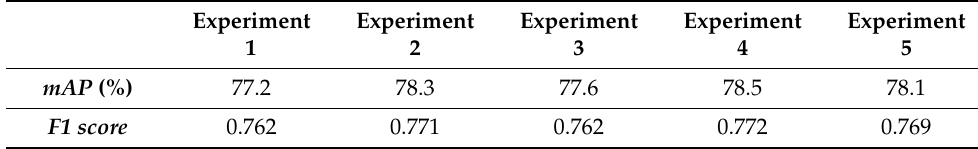
Table 9. Results of YOLOv5-DH on TT100K